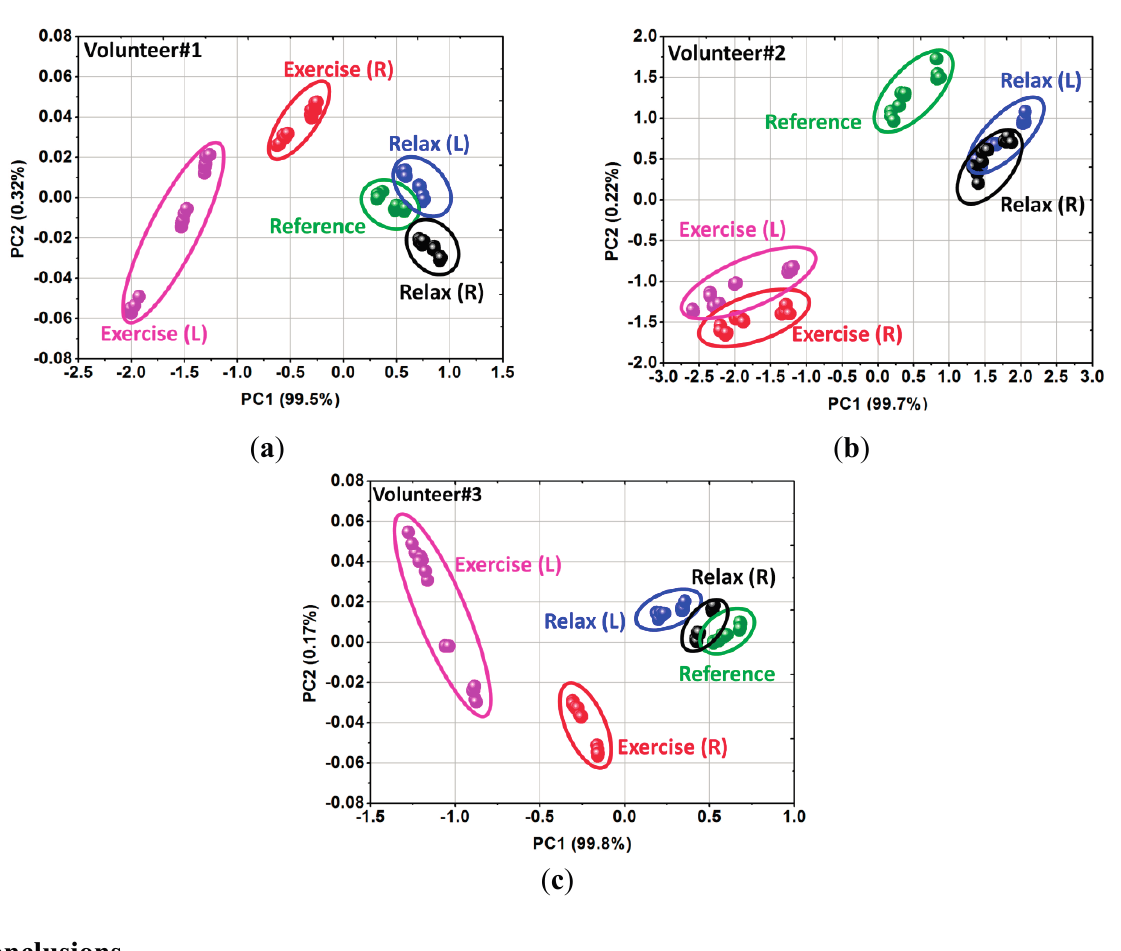
Figure 7. PCA scores plot of underarm odor under different activities: ( a ) volunteer#1; ( b ) volunteer#2 and ( c )